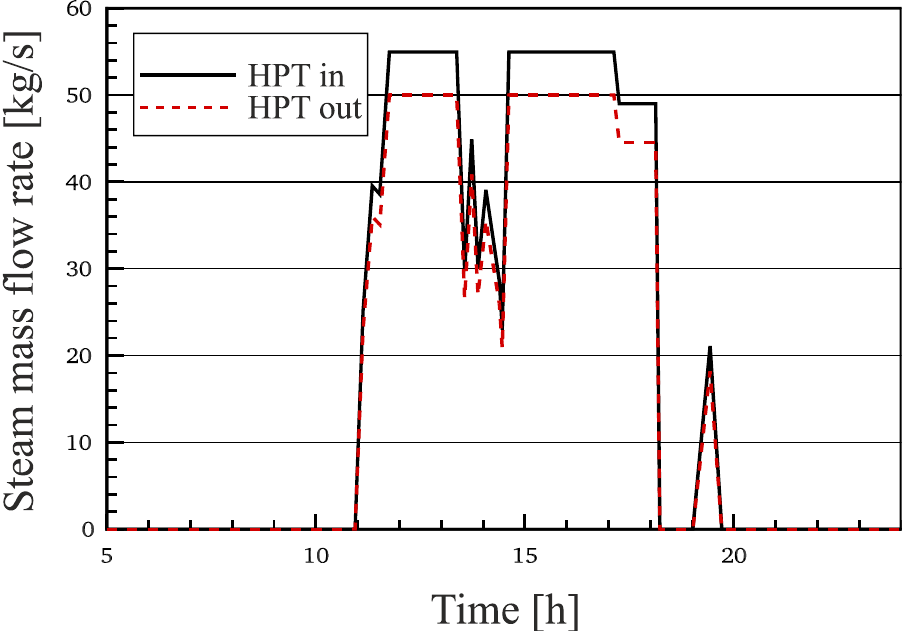
Figure 7. Simulated steam mass flow at the inlet and outlet of the HP turbine.